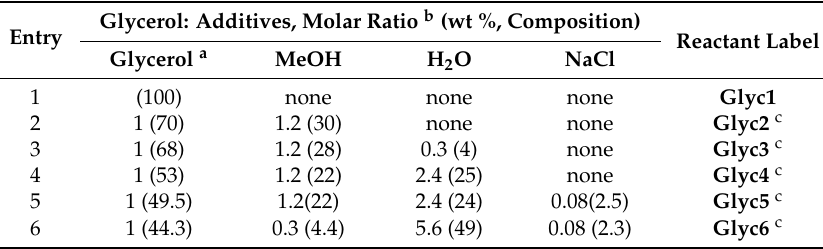
Table 1. Different types of glycerol used in this work.